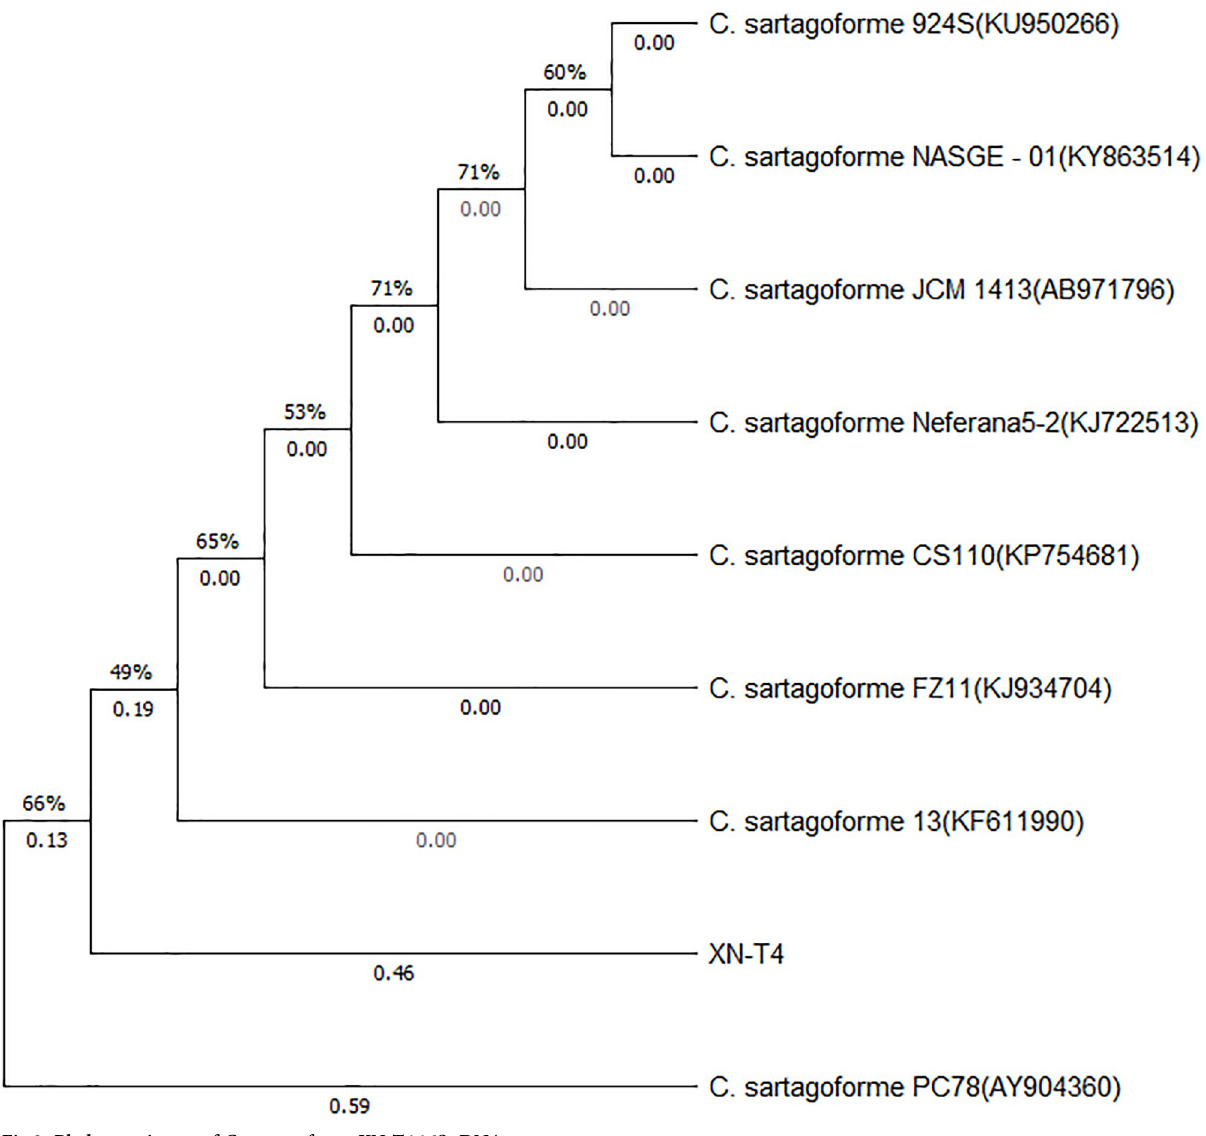
Fig 2. Phylogenetic tree of C . sartagoforme XN-T4 16S rDNA.